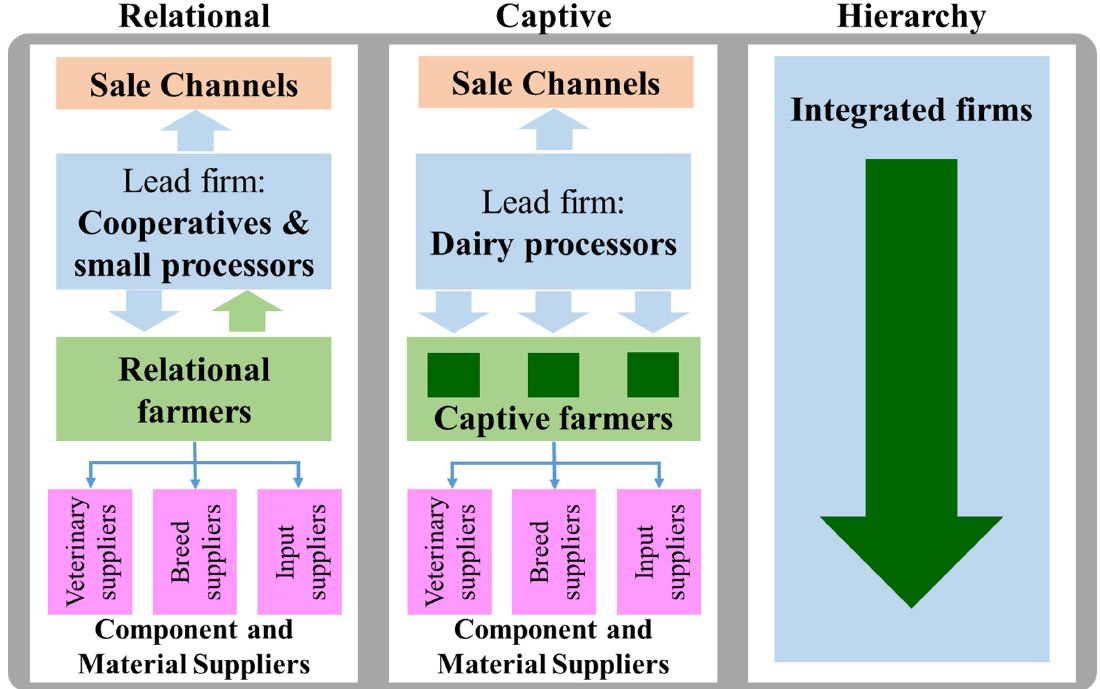
Figure 10. Three types of the milk value chain governance in